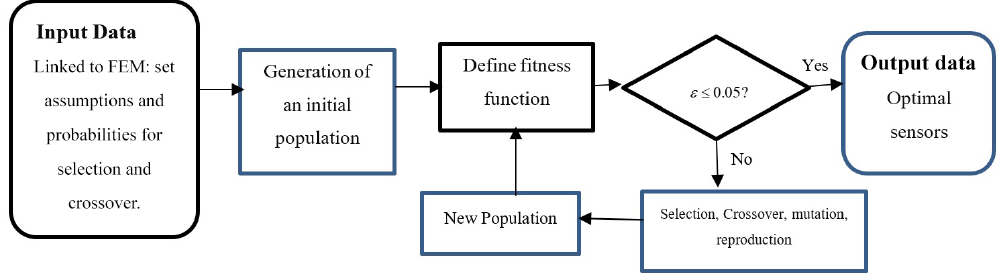
Figure 2. Algorithm for optimal sensor placement, based on the genetic algorithm.